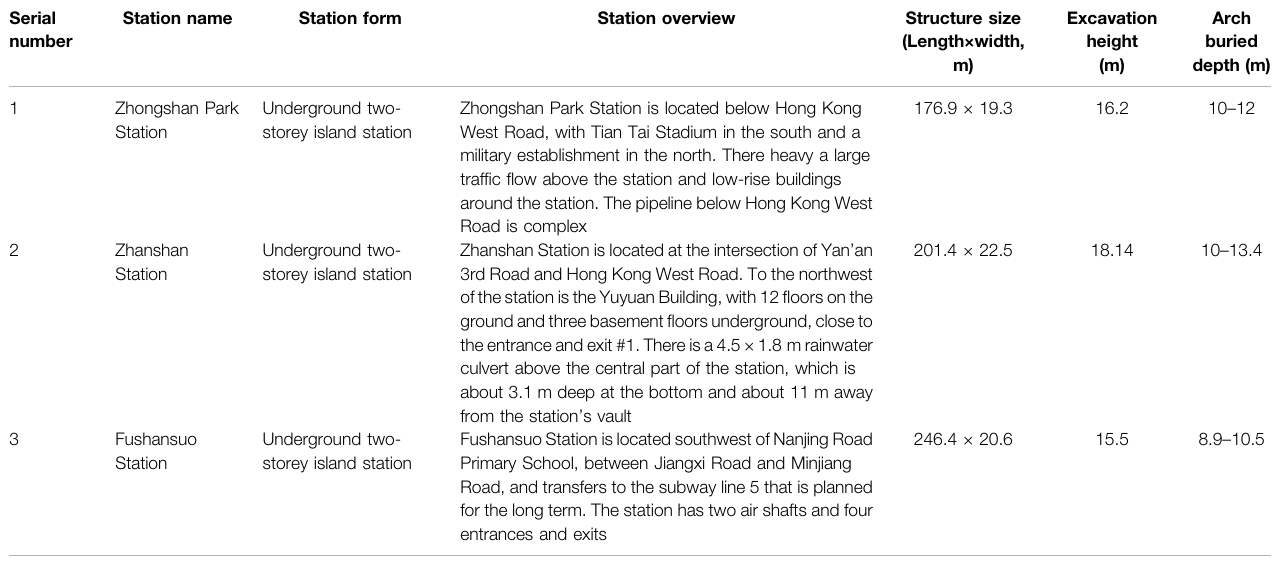
TABLE 2 | Basic information table of each underground station.